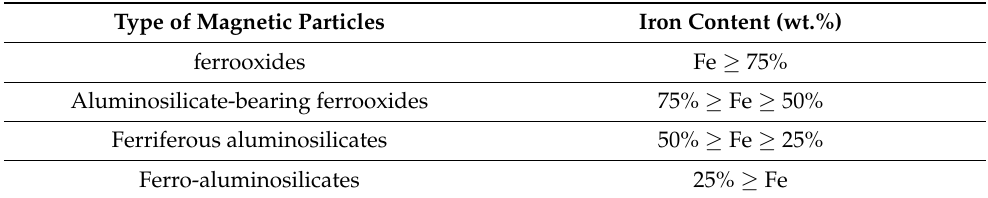
Table 1. Types of magnetic particles in fly ash formed during coal combustion [14]. Type of Magnetic